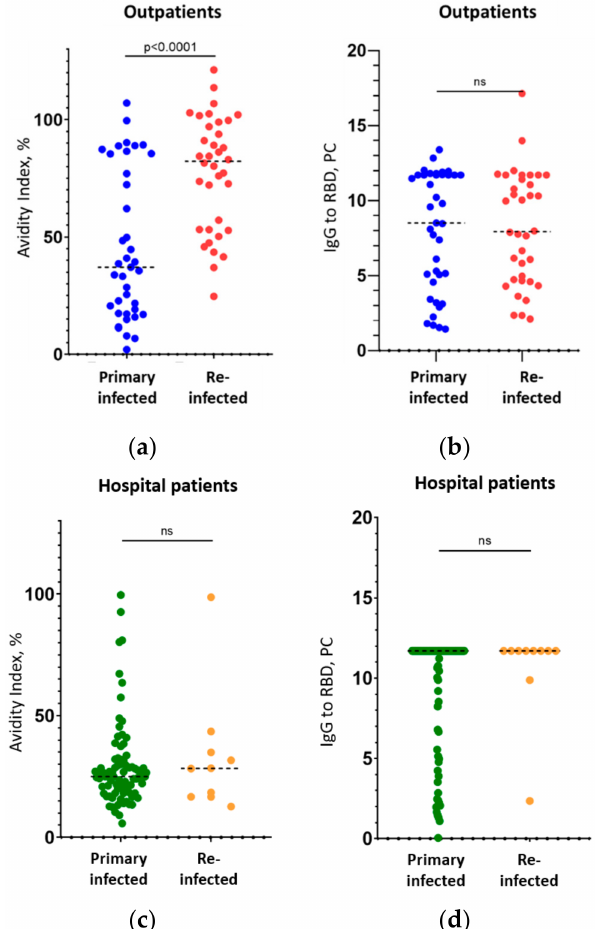
Figure 1. Avidity index ( a , c ) and IgG levels ( b , d ) in the study groups: outpatients with mild COVID- 19 ( a , b ) and hospital patients with a severe course of COVID-19 ( c , d ). Median values (dashed lines) are shown, as well as a Mann–Whitney test comparison of median values in the groups ”ns”, no significant difference). Numerical values are shown in Table